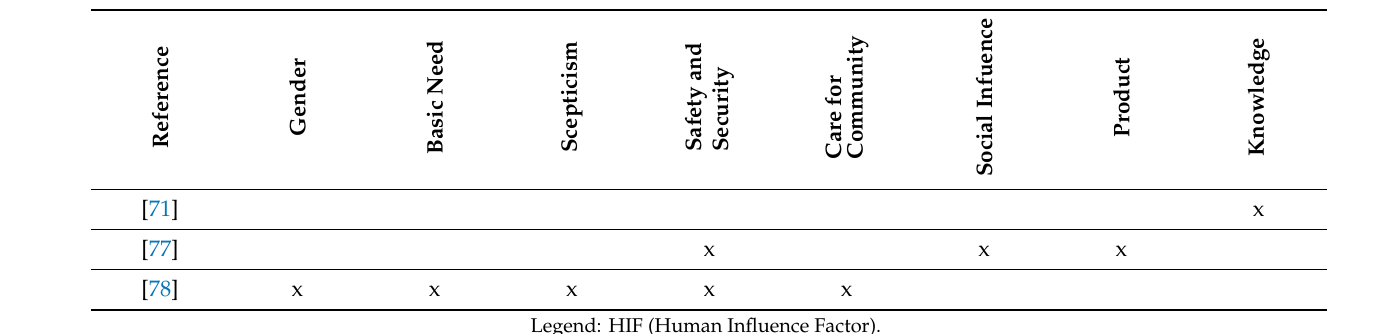
Table A5. The list of HIFs impacting security perception.